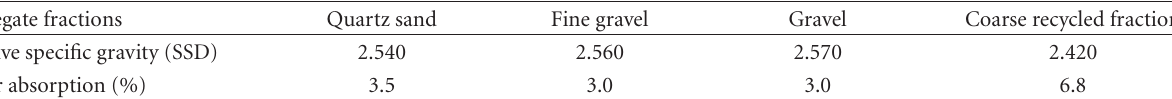
Table 1: Main physical properties of the aggregate fractions.